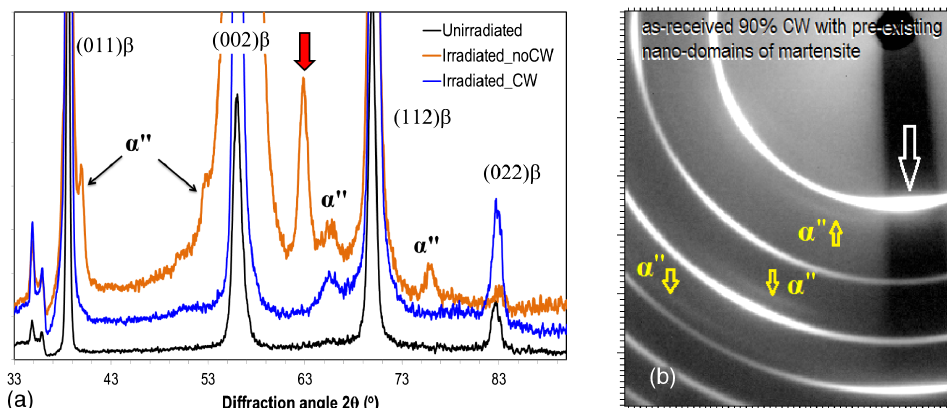
FIG. 18. (a) Observed phases and their evolution with irradiation in gum metal and (b) revealed presence of α ″ (orthorhombic) martensite nanodomains in 90% cold-worked gum metal and microstructure texture resulting from cold